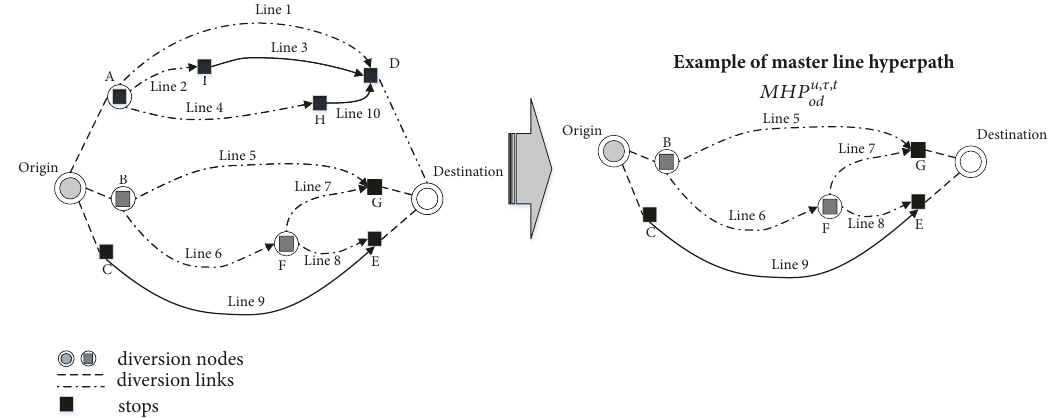
Figure 3: Example of a master line